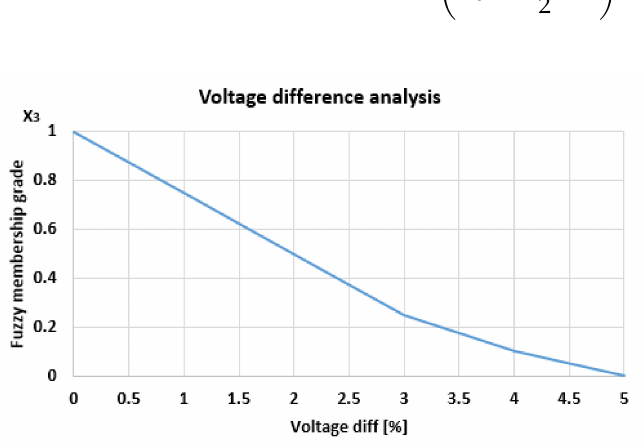
Figure 3. Voltage difference analysis.